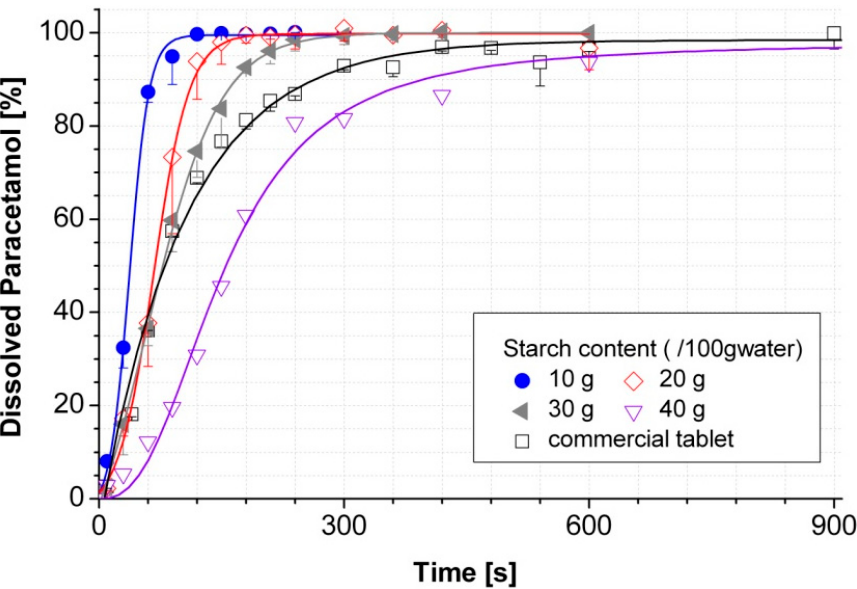
Figure 3. The dissolution profile of freeze casted paracetamol tablets in function of the modified starch contents [13].